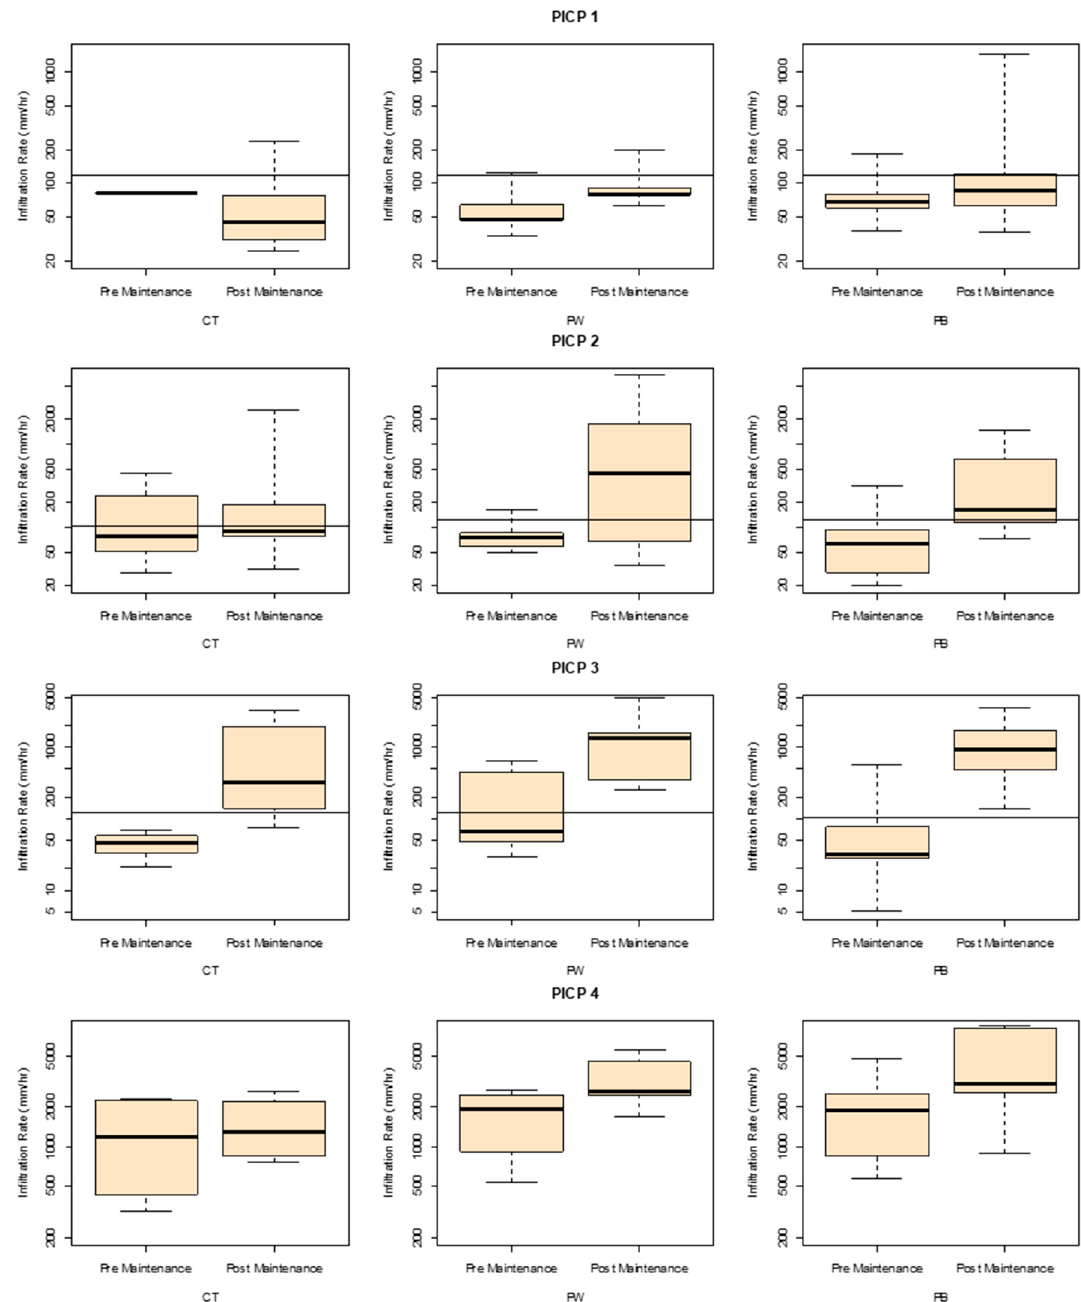
Figure 8. Boxplots for each surface treatment. Note: The horizonal line in the box plots represents the highest MDL of the dataset with multiple censoring limits. KM percentiles are plotted for values below the detection limit. CT: Control; PW: Pressure Wash; PB: Power Brush.